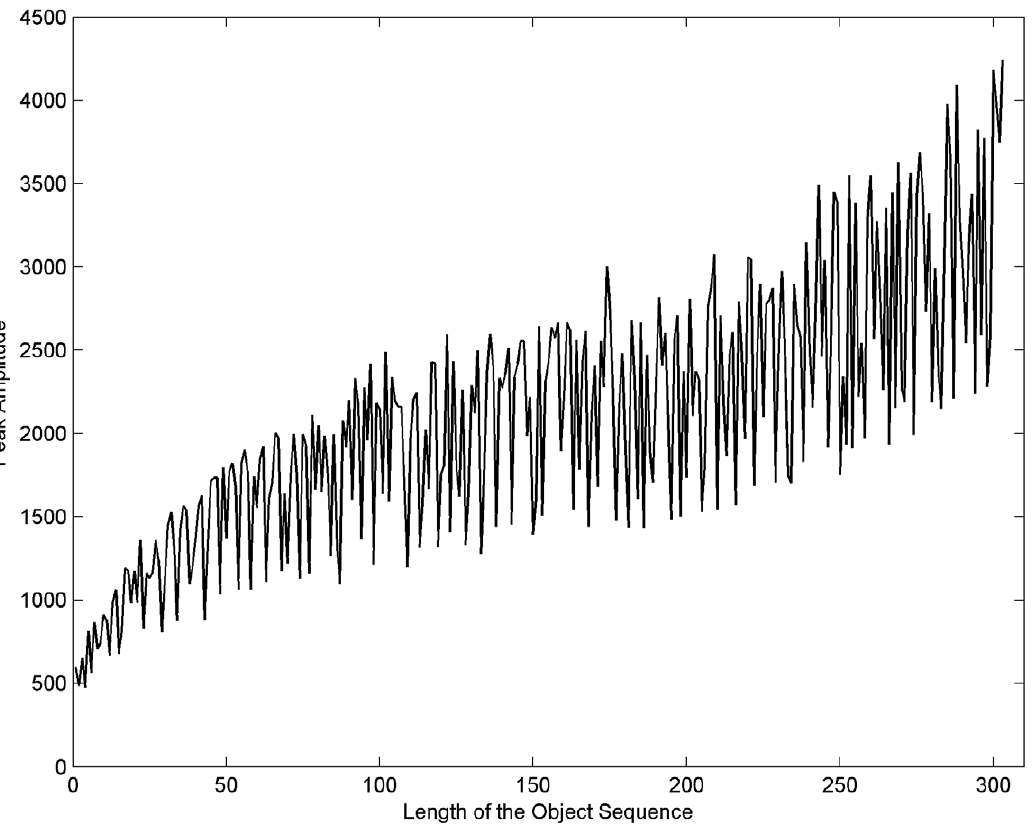
Figure 8. Peak and sequence length relationship . The amplitude of the peak in the correlation plane increases when the sequence length increases; however their relationship is not lineal.